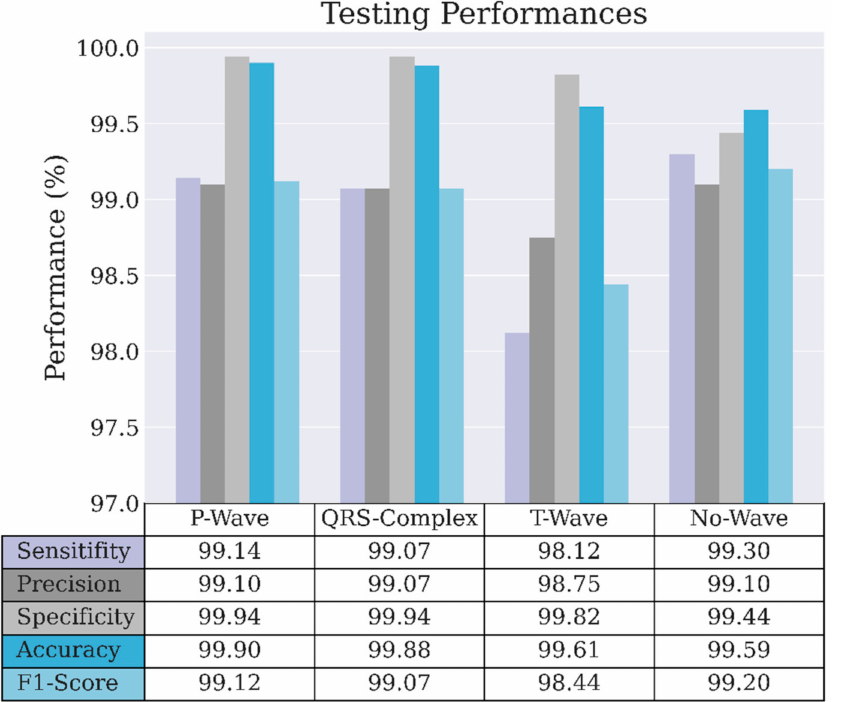
Figure 5. Model evaluation for the validation process in normal ECG